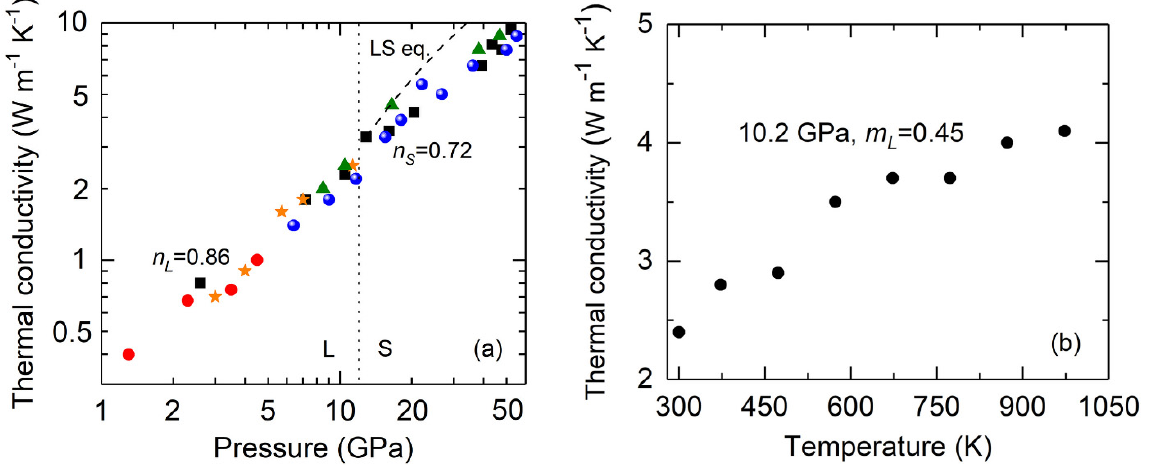
Figure 1. (a) Thermal conductivity of He at high pressure and room temperature . Several runs of measurements (represented by different symbols) show consistent results. In both liquid (L) and solid (S) phase, the thermal conductivity increases rapidly with pressure, with a slight increase of ~30% across the liquid–solid transition at ~12 GPa (vertical dotted line). The increasing rate of thermal conductivity with pressure in the solid phase [ n S = 0.72(±0.045)] is slightly smaller than that in the liquid phase [ n L = 0.86(±0.048)]. The uncertainty is typically ~13% before 30 GPa and ~20% at 30–50 GPa. Compared to our experimental data, the LS equation (dashed curve) predicts a higher thermal conductivity of solid He with a larger pressure slope. (b) Temperature dependence of the thermal conductivity of liquid He at 10.2 GPa. The thermal conductivity of the liquid phase (with an analysis uncertainty of ~15%) scales with T mL , where m L = 0.45(±0.036).